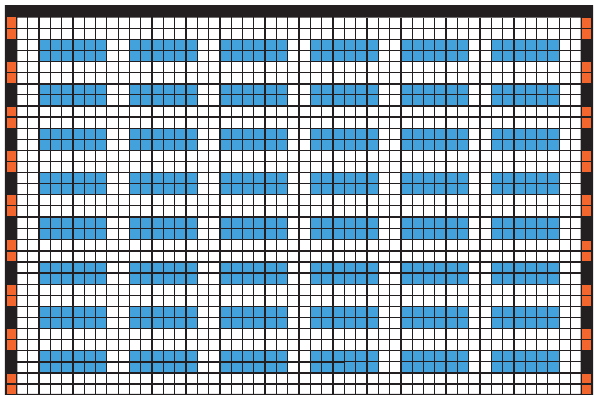
Figure 1: The discretized map of the warehouse. The orange and blue squares represent pickup points of the shelves and storage points, respectively. Other squares represent feasible ways.